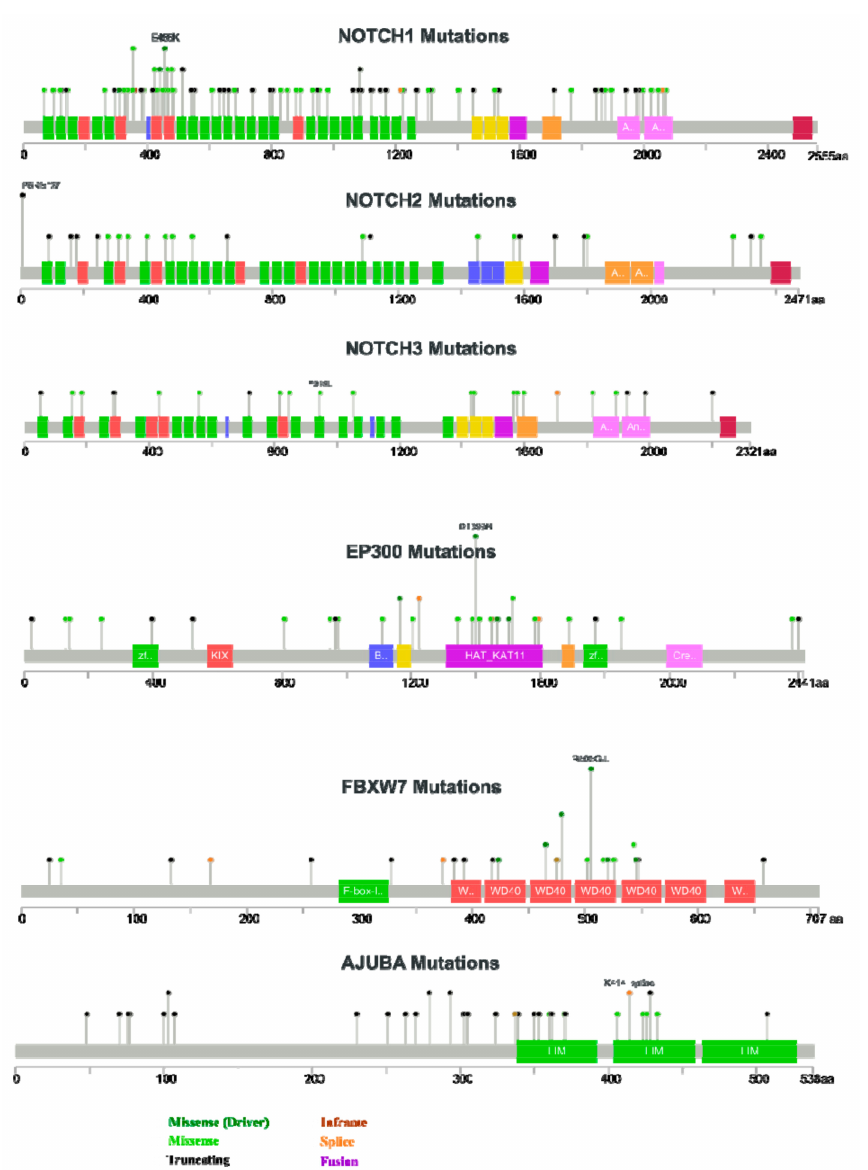
Figure 5. Lack of mutation hotspots in Notch pathway-specific target genes NOTCH1 - 3 , Histone Acetyltransferase P300 ( EP300 ), LIM Domain-Containing protein Ajuba ( AJUBA ), and F-Box and WD Repeat Domain Containing protein 7 ( FBXW7 ). NOTCH receptor mutations are evenly spread across the entire length of extracellular protein domains, likely resulting in loss-of-function mutations and truncated proteins. Mutations in other Notch-related target genes such as EP300 and AJUBA also do not show any prominent, recurrent hotspots, but can be focused on functional domains, such as the HAT/histone acetylation domain of EP300